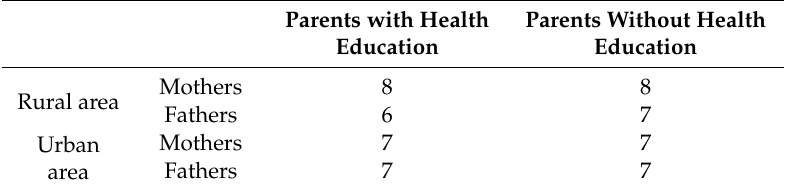
Table 2. Organization of the focus groups.